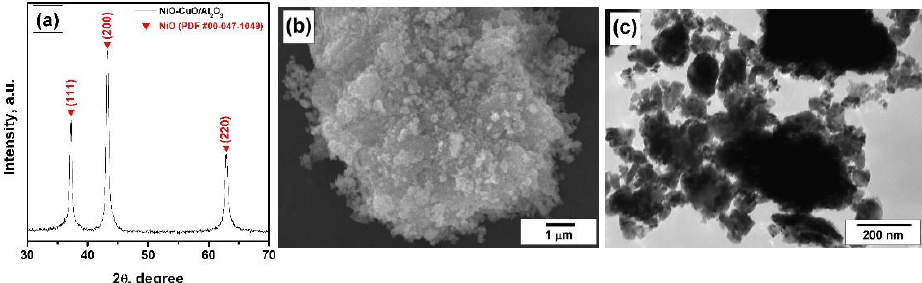
Figure 3. XRD pattern ( a ), SEM ( b ) and TEM ( c ) images of the catalyst prepared by the mechanochemical activation method.